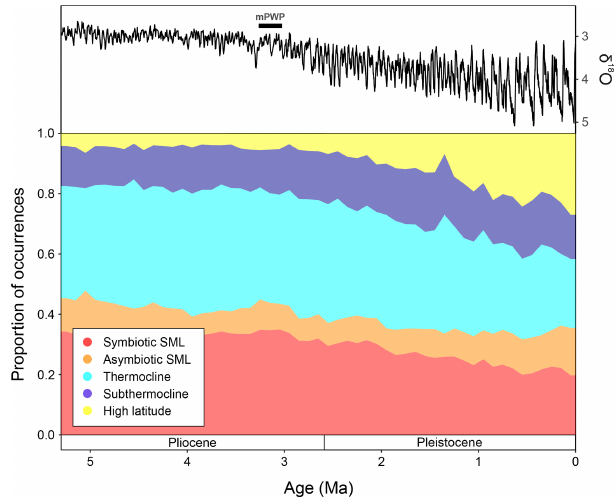
Figure 5. The LR04 stack showing benthic foraminiferal δ 18 O (from Lisiecki and Raymo, 2005) and proportions of macroperfo- rate planktonic foraminifera occurrences assigned to the ecogroups of Aze et al. (2011), binned to 100kyrs from 5.3Ma to the Recent. mPWP = mid-Pliocene Warm Period, SML = surface